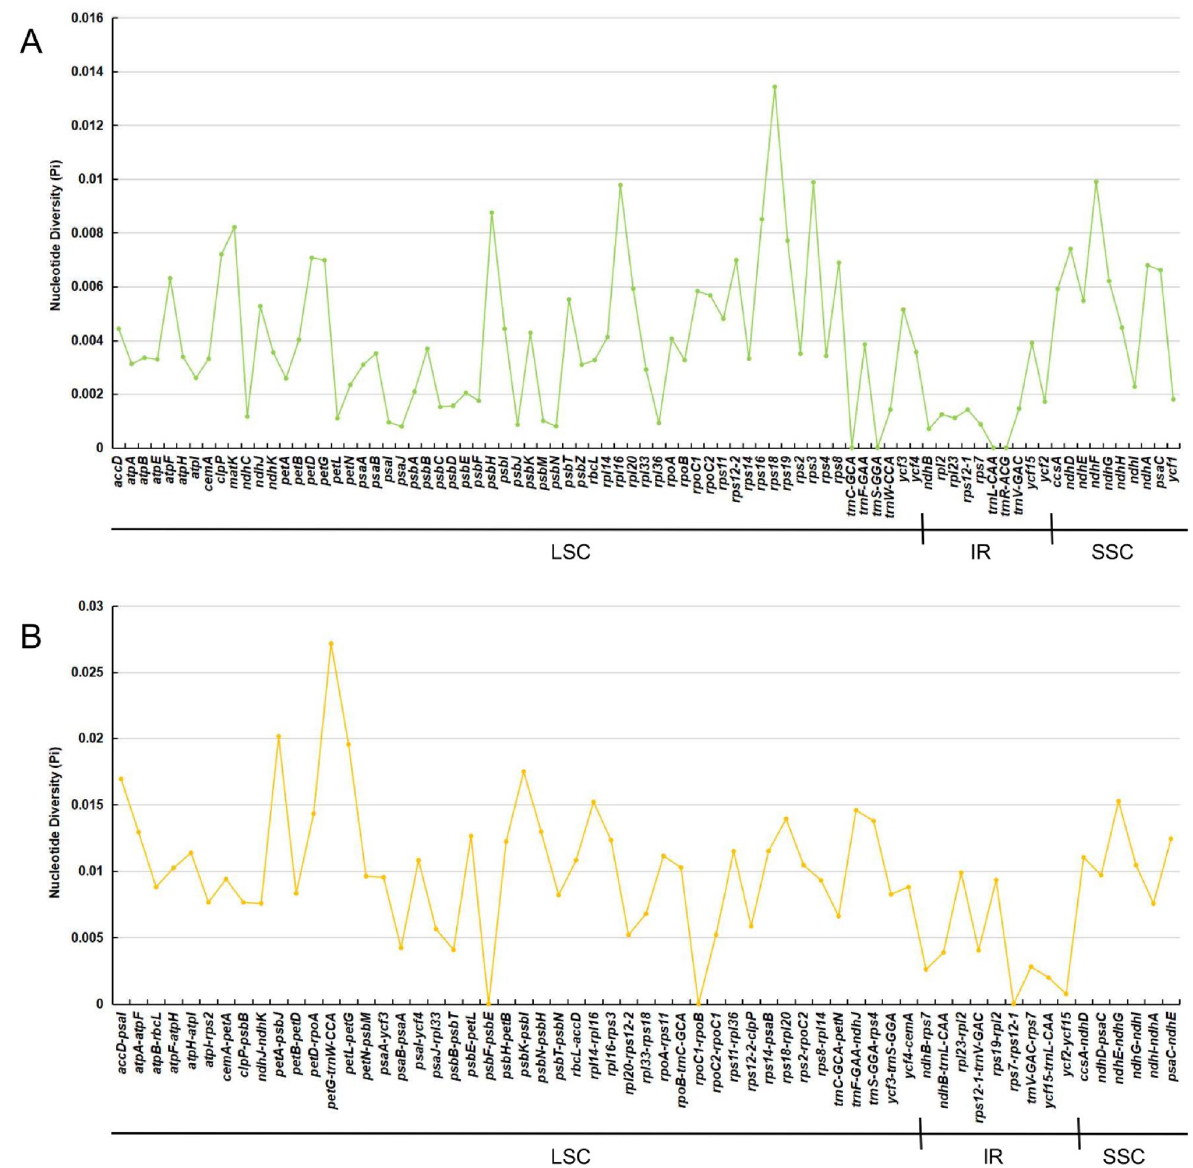
Figure 7. Nucleotide diversity (Pi) of shared various regions in 19 Paeoniaceae species chloroplast genomes. ( A ) Pi values in the genes regions. ( B ) Pi values in the intergenic spacers